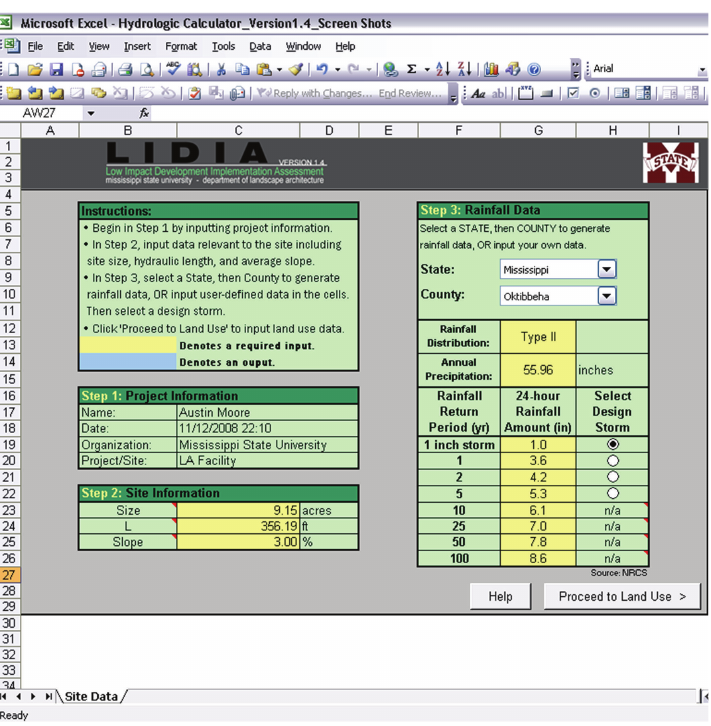
Figure 16: Latis-LIDIA Site Data Input